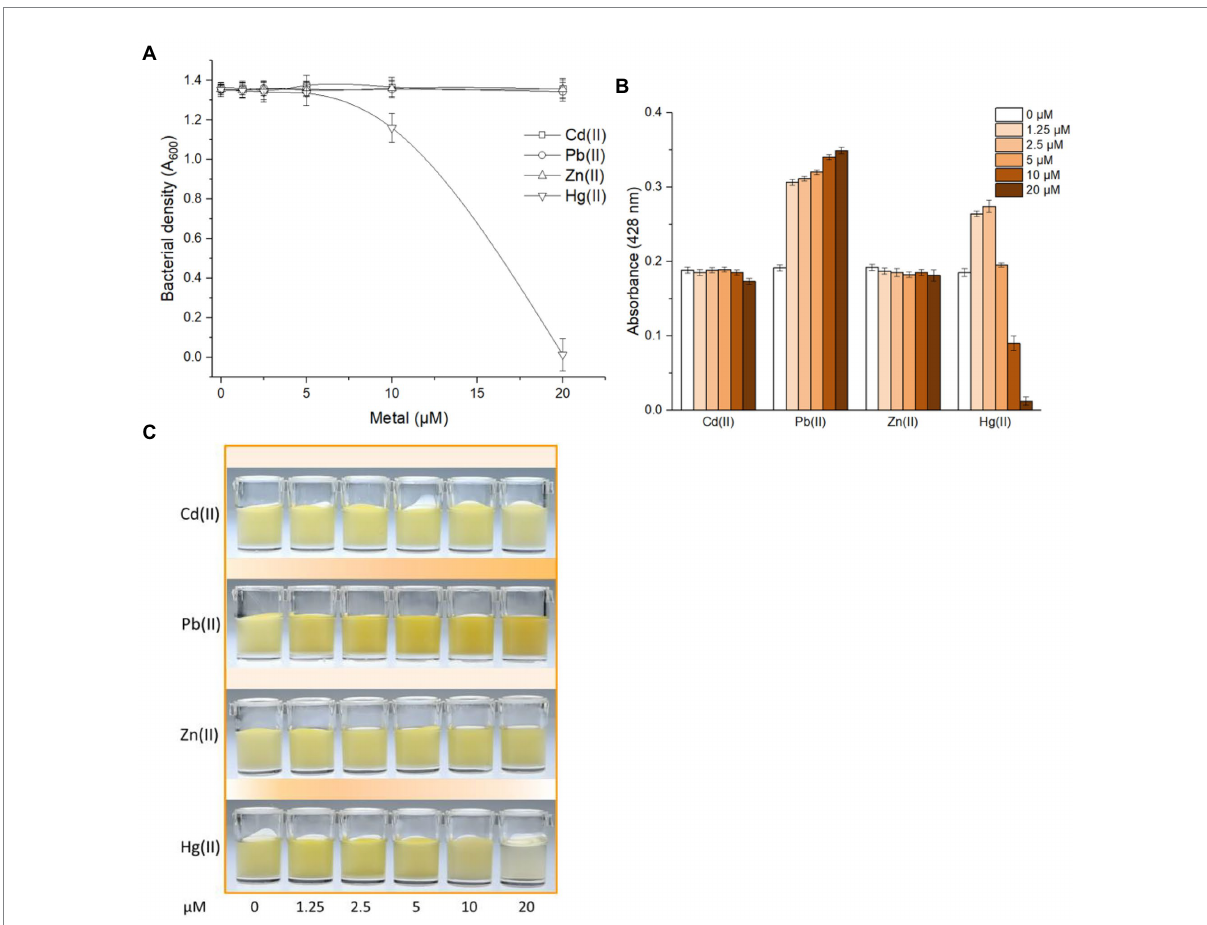
FIGURE 3 Differential responses of TOP10/pPb-CACD toward various metal ions. TOP10/pPb-CACD was inoculated into fresh LB medium supplemented with 1 mM catechin and exposed to increased concentrations of Cd(II), Pb(II), Zn(II), or Hg(II). After culture at 37 ° C overnight, bacterial cell densities (A) and pigment signal (B) was measured at 600 nm and 428 nm, respectively. Data represent the average of three independent assays with similar results and error bars represent standard deviations. Data shown are mean ± SD ( n = 3). A representative picture of induced cultures (C) was chosen from three independent tests with similar